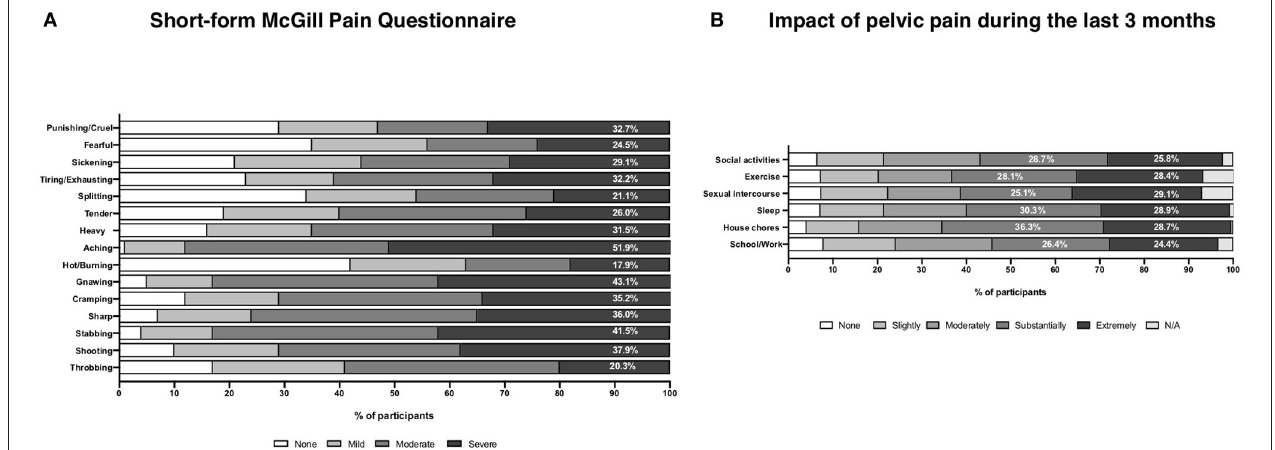
FIGURE 7 | Pain characteristics and impact of pelvic pain on lifestyle. (A) Pain characteristics by the McGill Pain Questionnaire Short Form results. (B) The impact of pelvic pain during the last 3 months.